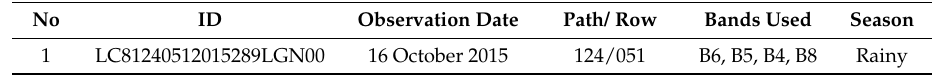
Table 2. Landsat 8 data used in this